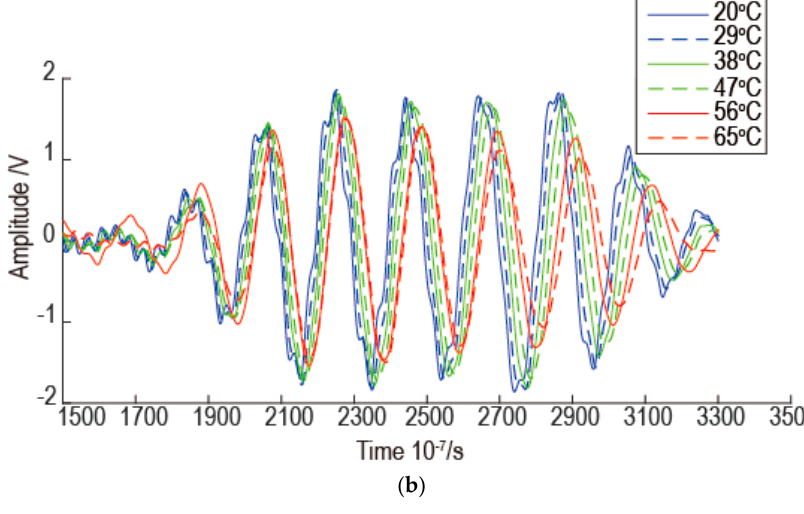
Figure 4. Signals with frequency 50 kHz at different temperatures. ( a ) A waterfall plot of the whole waveform; ( b ) Wave packet 1.